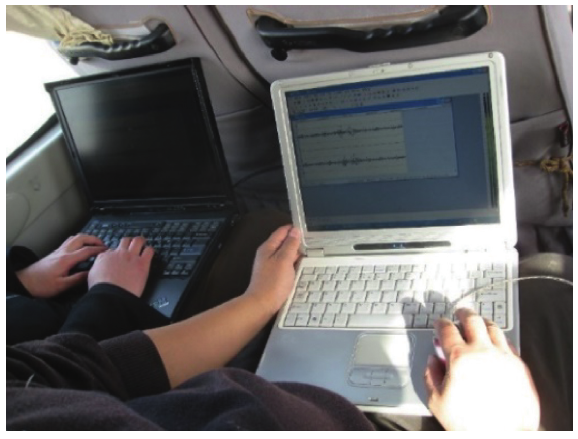
Figure 9: Data collection.